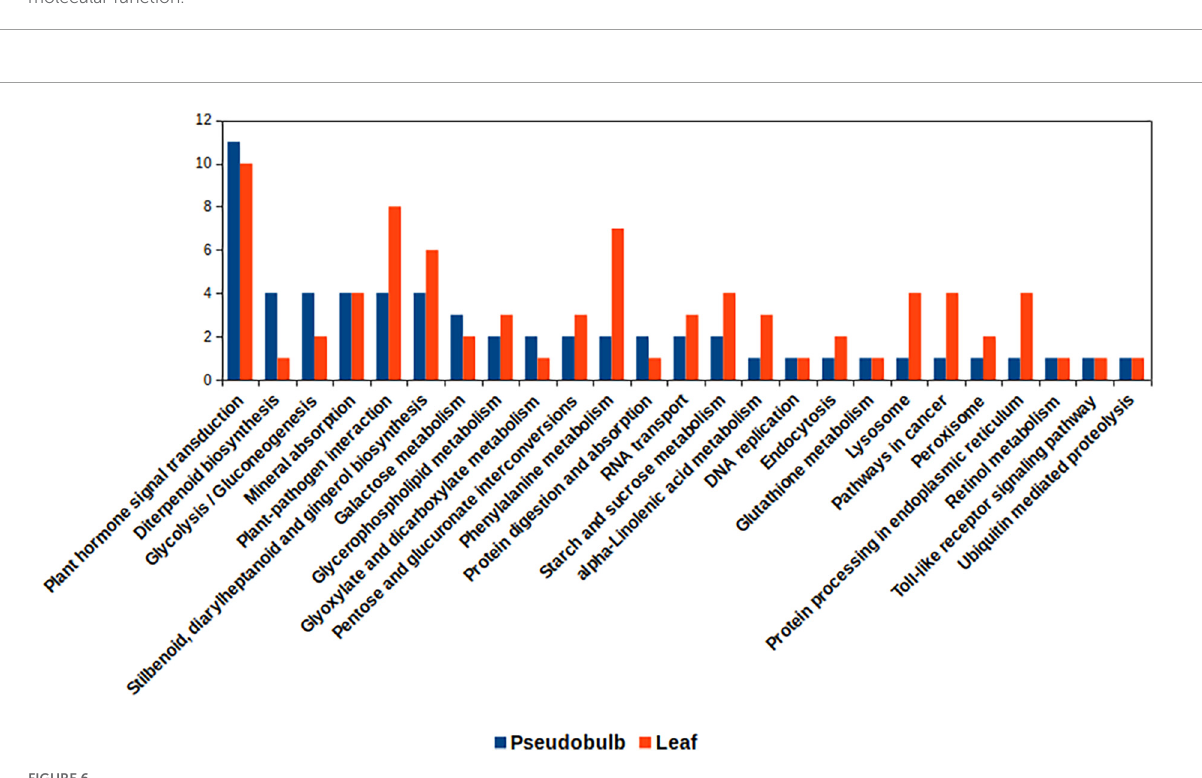
FIGURE6 Kyoto encyclopedia of genes and genomes (KEGG) pathways associated with differentially expressed genes for leaf and pseudobulb in M. acuminata.